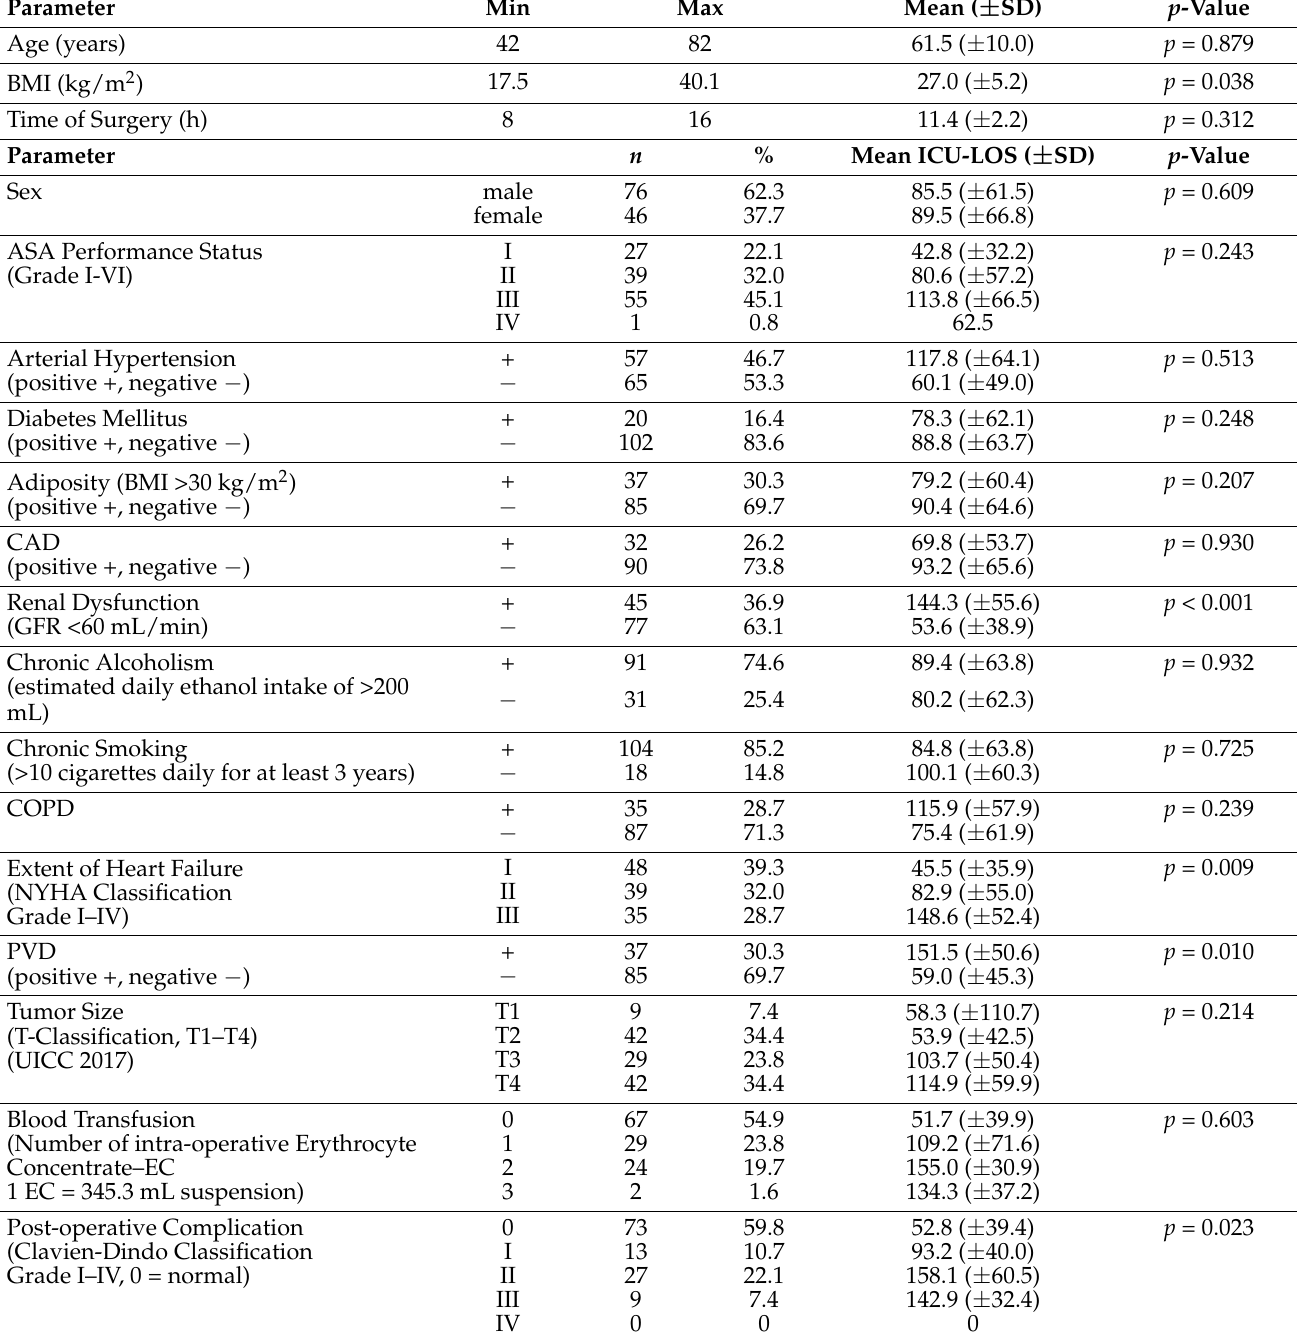
Table 4. Numerical and categorical analysis of pre-operative parameters in correlation to ICU-LOS given in hours ( n = 122). The table shows a univariate general linear model of regression that was conducted to assess the correlation of several variables with the primary outcome of interest, ICU-LOS. This regression model calculates the association of several pre-operative patient risk factors and parameters (variables) with the primary outcome of interest, ICU-LOS, by considering the variety of multiple possible confounders that may additionally influence ICU-LOS in parallel. The table also includes the analysis of post-operative complications. p -values of <0.05 were considered statistically significant. The correlation between observed and predicted (calculated) values (proof of regression model’s validity) was calculated with R 2 (0–1) = 0.739